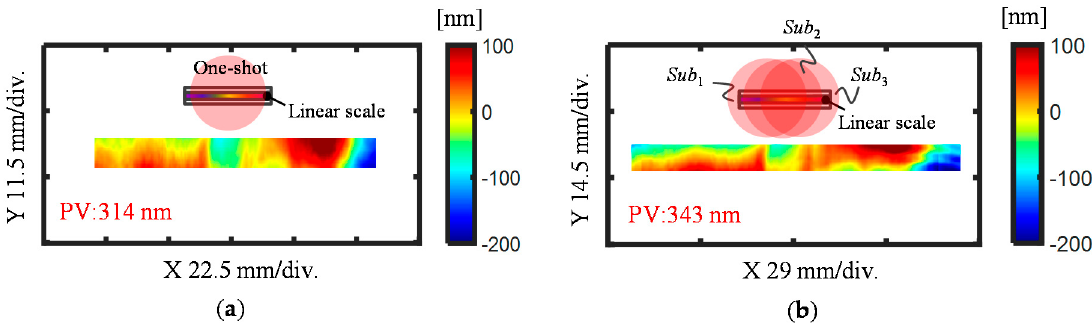
Figure 14. Evaluated pitch deviation of the linear scale through one-shot and three-shot measurements. ( a ) Pitch deviation of the linear scale evaluated with a one-shot measurement; ( b ) Pitch deviation of the linear scale evaluated with a three-shot measurement and stitching method.